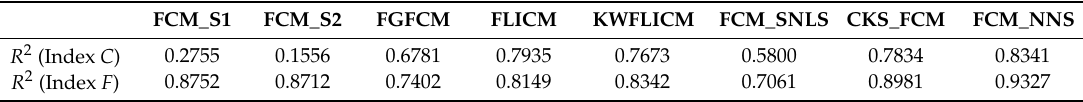
Table 5. Correlation coe ffi cient values of the improved FCM-based roughness